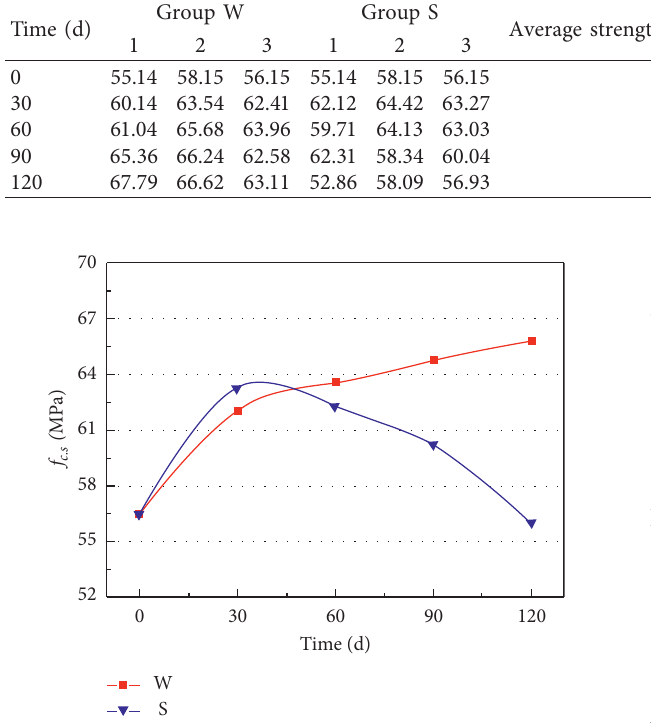
Figure 8: Variation of compressive strength of concrete specimens over time.